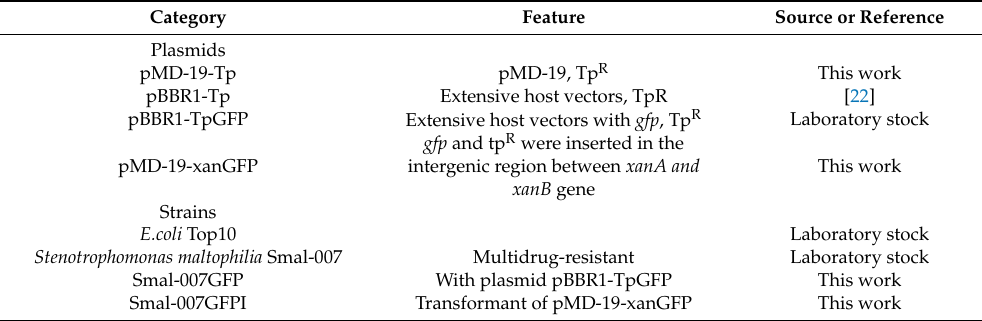
Table 1. Strains and